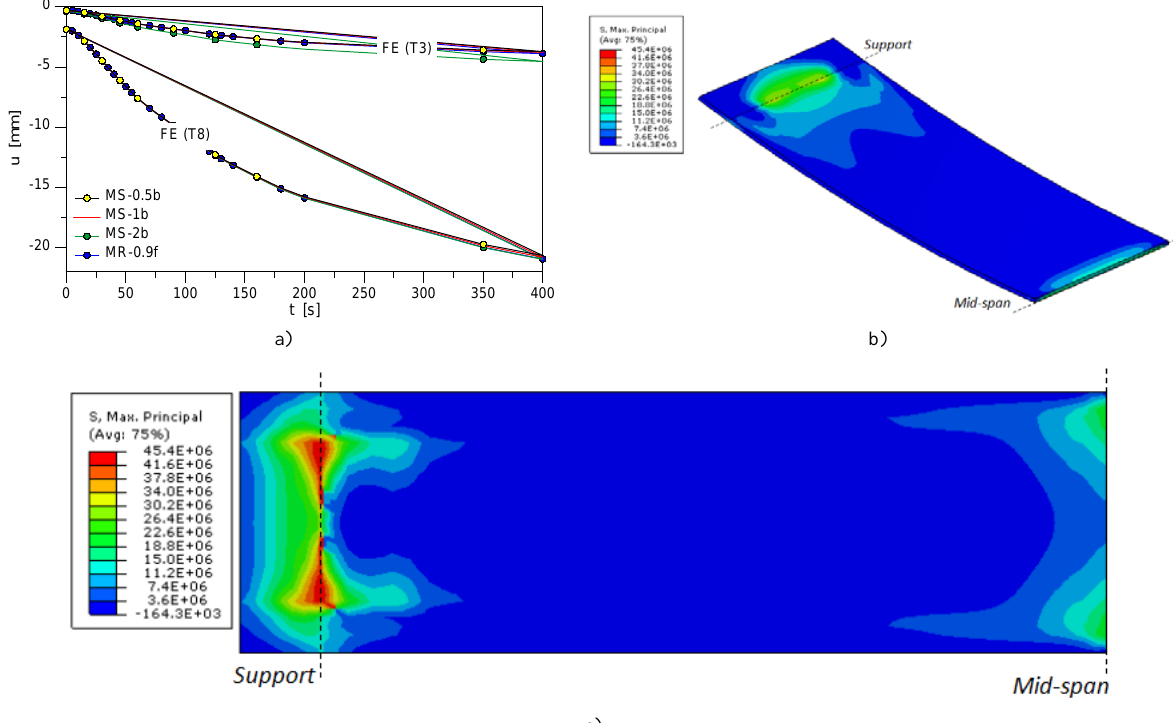
Fig. 10 Thermo-mechanical analyses: a) variation of maximum deflections in time and b)-c) stress distribution in glass (axonometry&bottom view, MR-09f model) after 125s of fire exposure (legend in